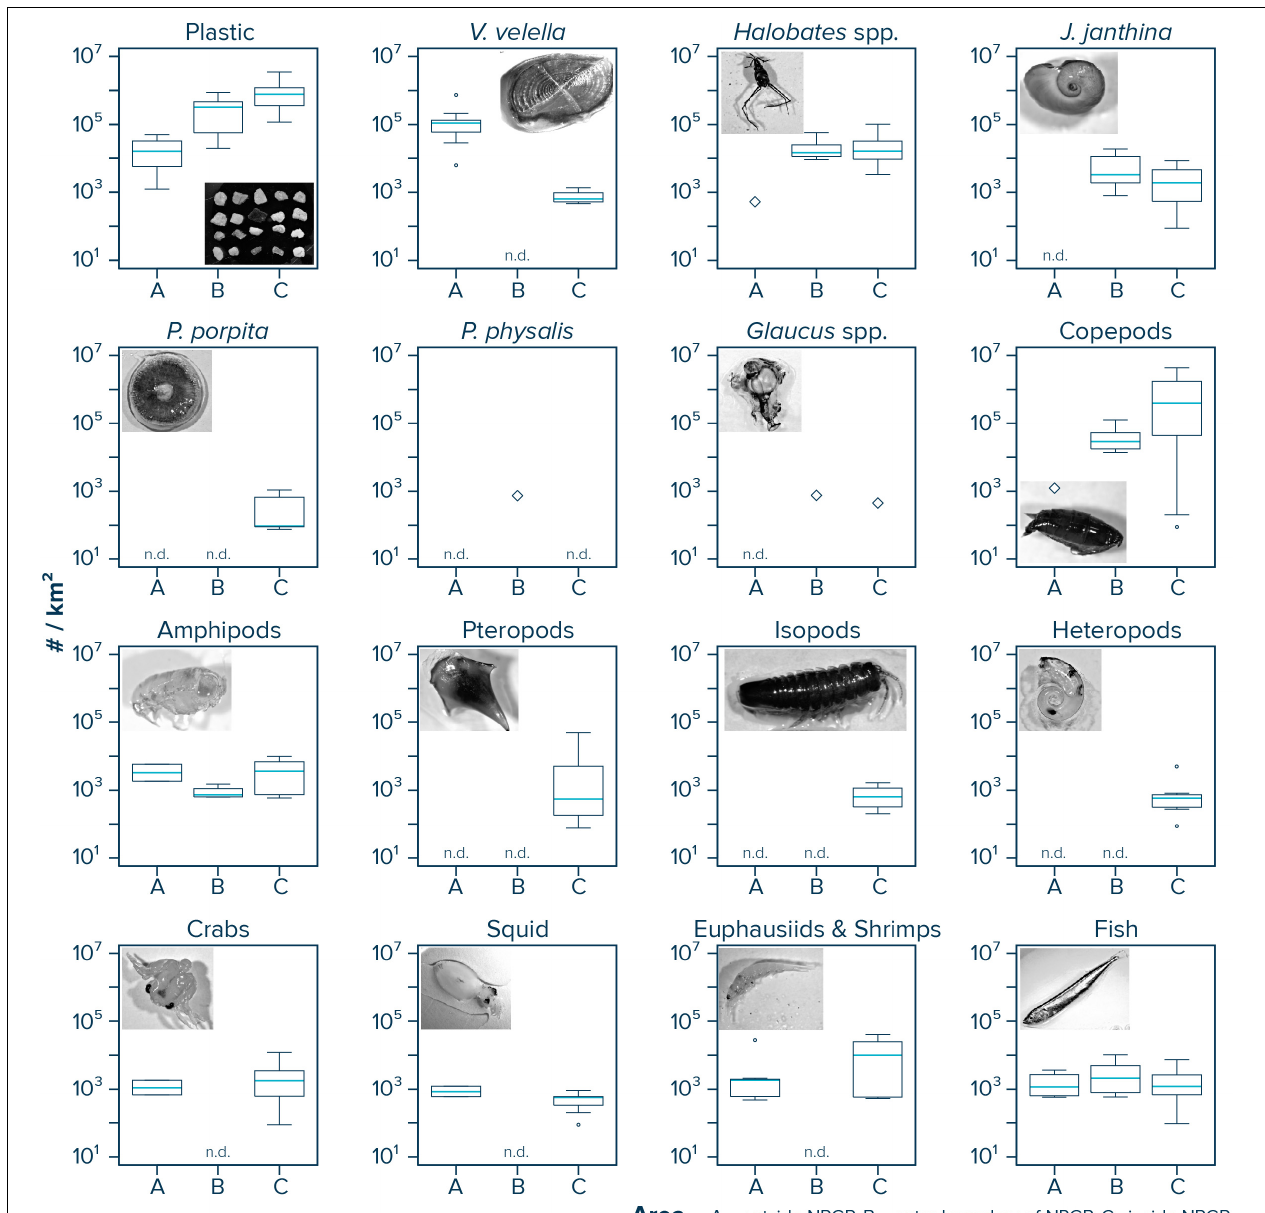
FIGURE 2 | Numerical concentrations (#/km 2 ) of floating plastic debris (0.05–5 cm in size) and of different members of the neuston observed in Manta trawls deployed outside the NPGP (Area A), in the outer boundary of the NPGP (Area B), and inside the NPGP (Area C). Horizontal lines represent median values. Box plots extend from the 25th to the 75th percentiles, while whiskers extend from the minimum to the maximum observed values. Large diamonds indicate that the species was only present in one Manta trawl. Dots indicate outliers. n.d., not detected in any of the Manta trawls. Note that plastic concentrations represent depth-integrated